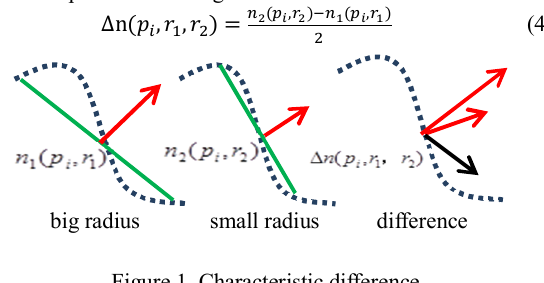
Figure 1. Characteristic difference